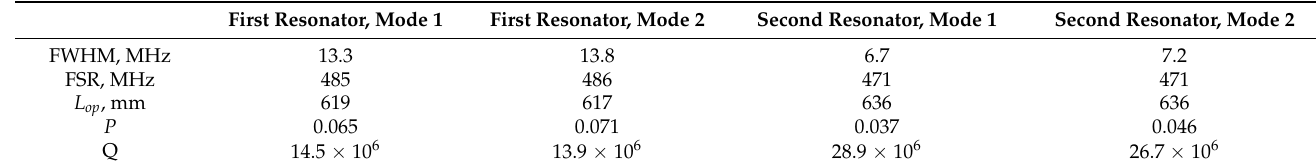
Figure 5. Experimentally (blue solid curve) and analytically (red dashed line) obtained frequency characteristics of mode 1 of the first resonator ( a ) and the same on a different scale ( b ).